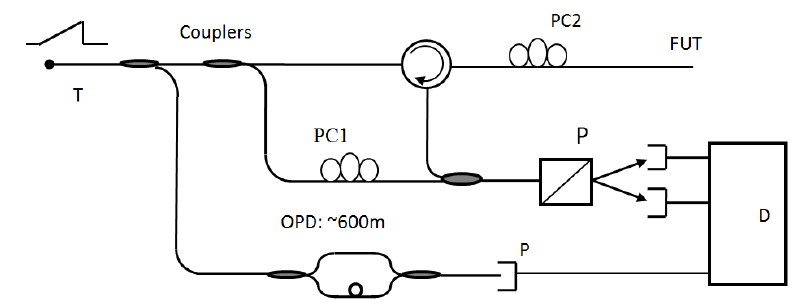
Figure 4. Experimental setup of